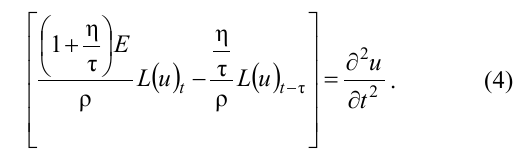
Fig. 3. The experimental